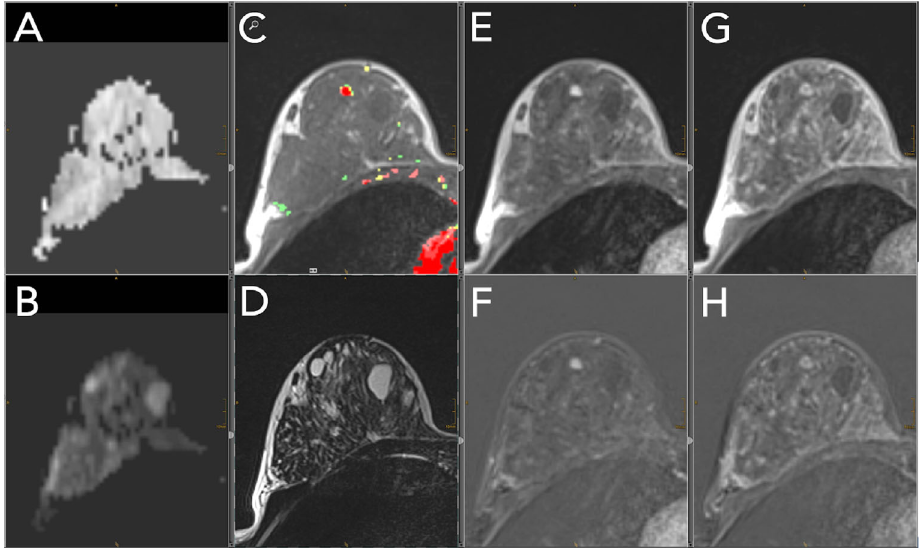
Fig. 2 Standardised hanging protocol/reading layout for a two-screen solution. Standardised hanging protocols decrease the reading time and increase diagnostic confidence while reducing potential sources of errors. All series should be linked, allowing simultaneous scrolling and zooming. This example shows a 44-year-old high-risk patient. A: ADC map; B: high b-value DWI image; C: pre-contrast T1w (here with superimposed colour-coded enhancement map indicating dominant wash-out, coded in red); D: T2w-TSE; E/F: early